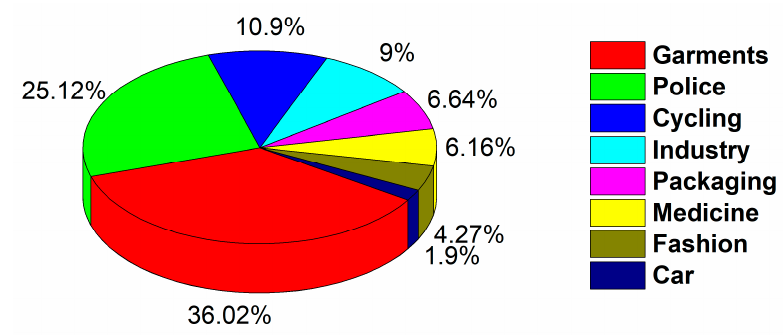
Figure 9. Eight areas for sensor integration in textiles in November 2019.